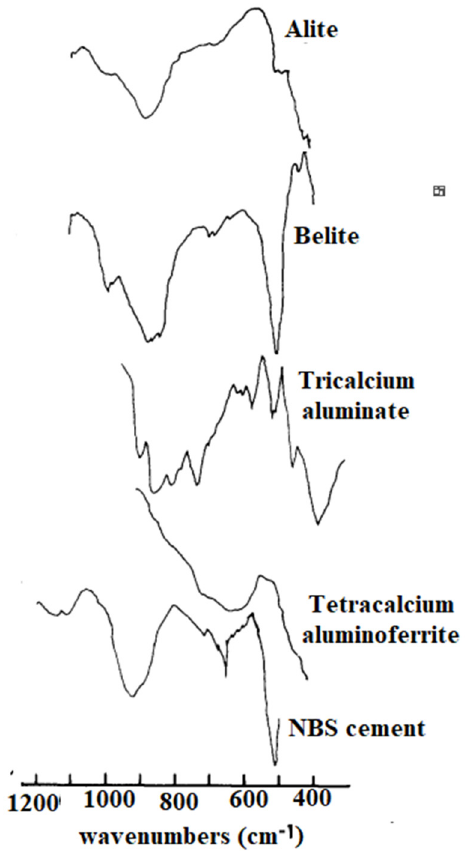
Figure 3. FTIR spectra of anhydrous cement phases (From Elsevier Ref. [53] and used with permission).